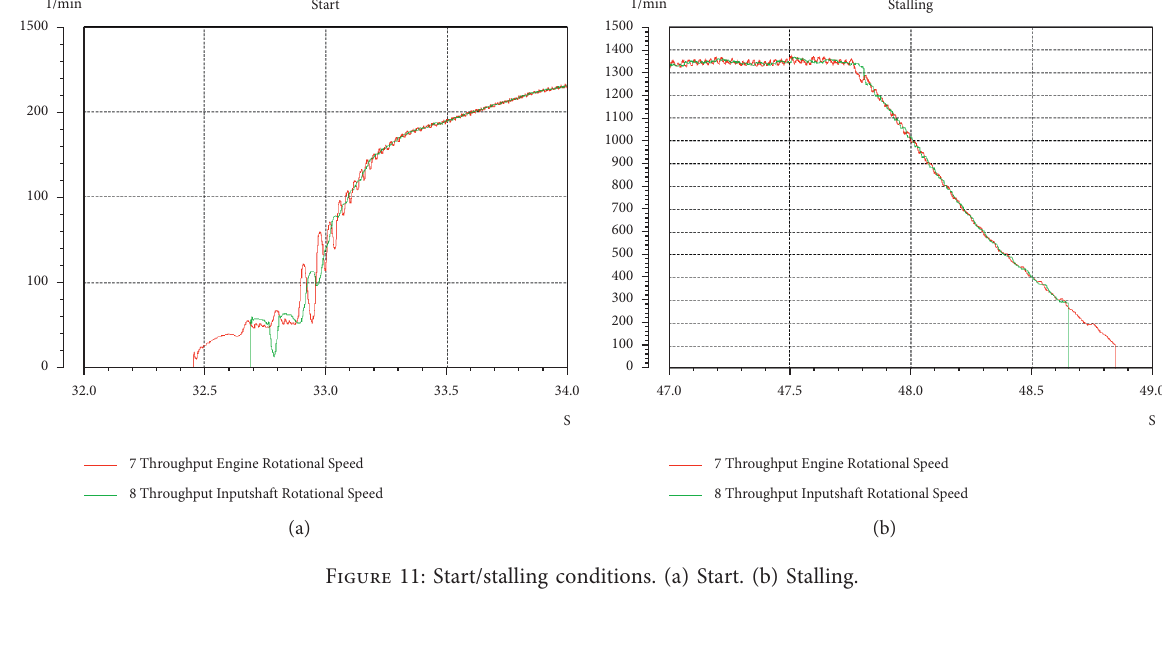
Figure 11: Start/stalling conditions. (a) Start. (b) Stalling.